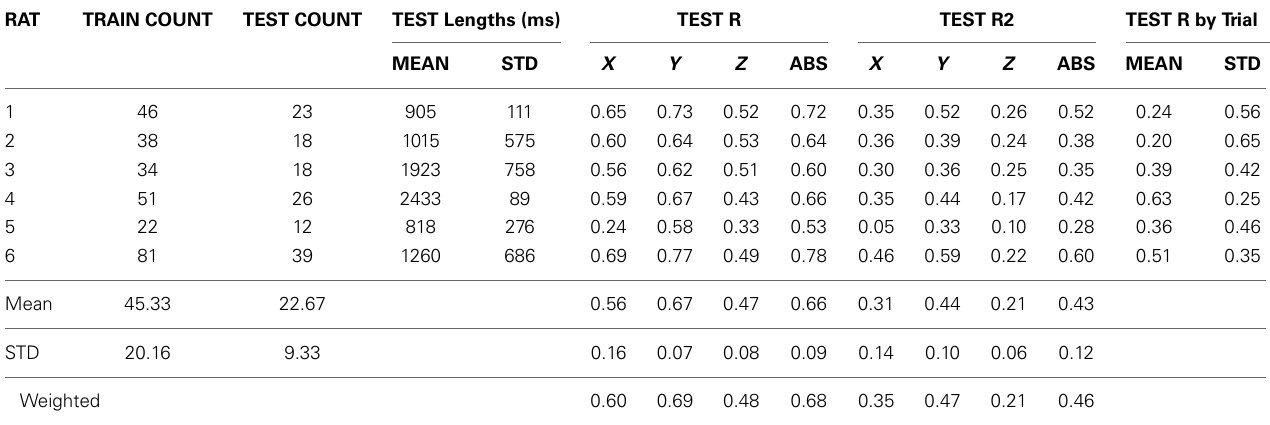
Table 1 | Group statistics of test